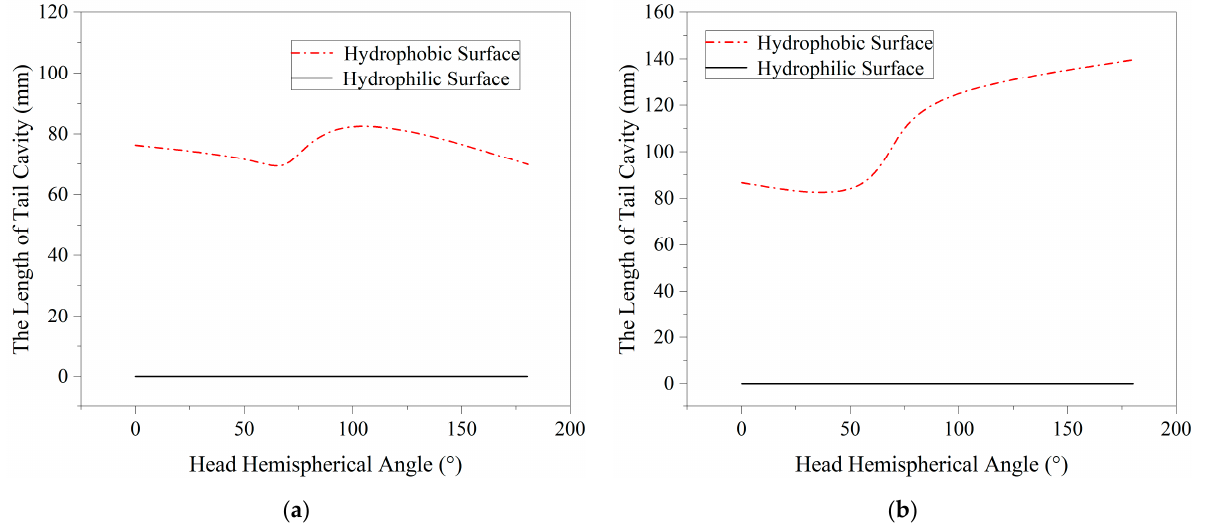
Figure 25. Cavity depths of the water entry at a water entry velocity of 3.95 m/s. ( a ) Cavity at the tail. ( b ) Cavity at the head.